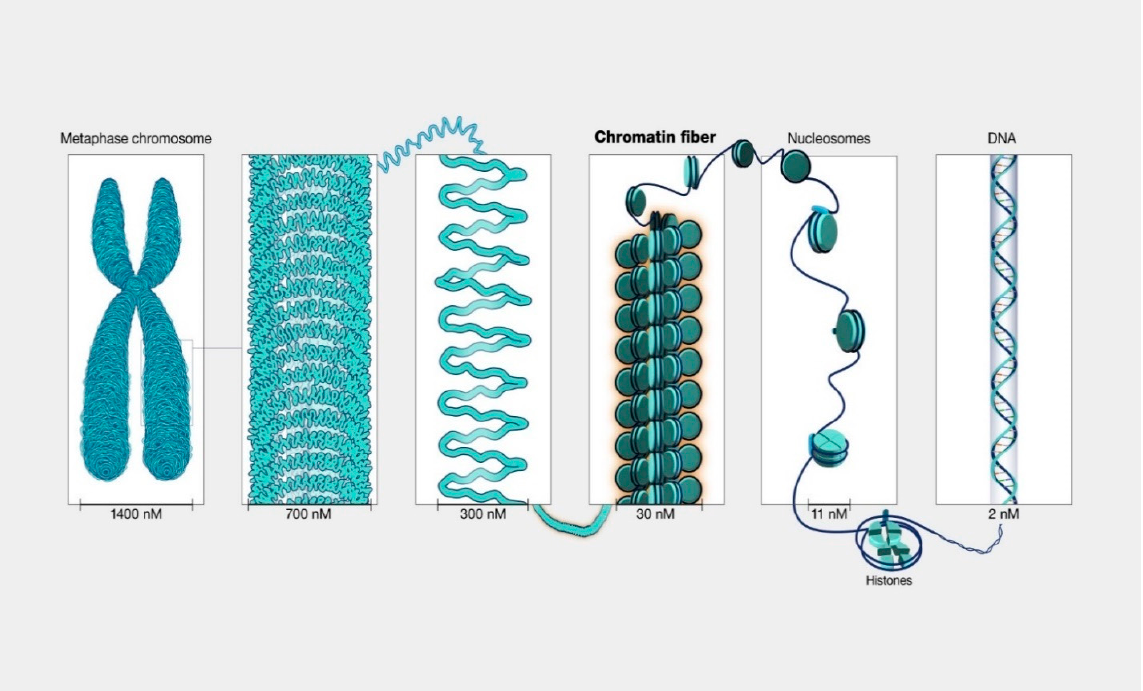
Figure 1. The structure of chromatin within a chromosome. Chromatin refers to a mixture of DNA and proteins that form the chromosomes found in the cells of humans and other higher organisms. Many of the proteins, namely histones, package the massive amount of DNA in a genome into a highly compact form that can fit in the cell nucleus. Courtesy: National Human Genome Research Institute.